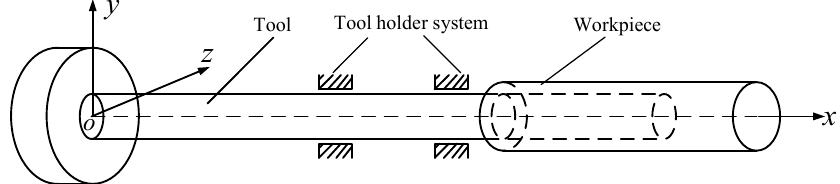
Figure 3. Equivalent model of the machining system.